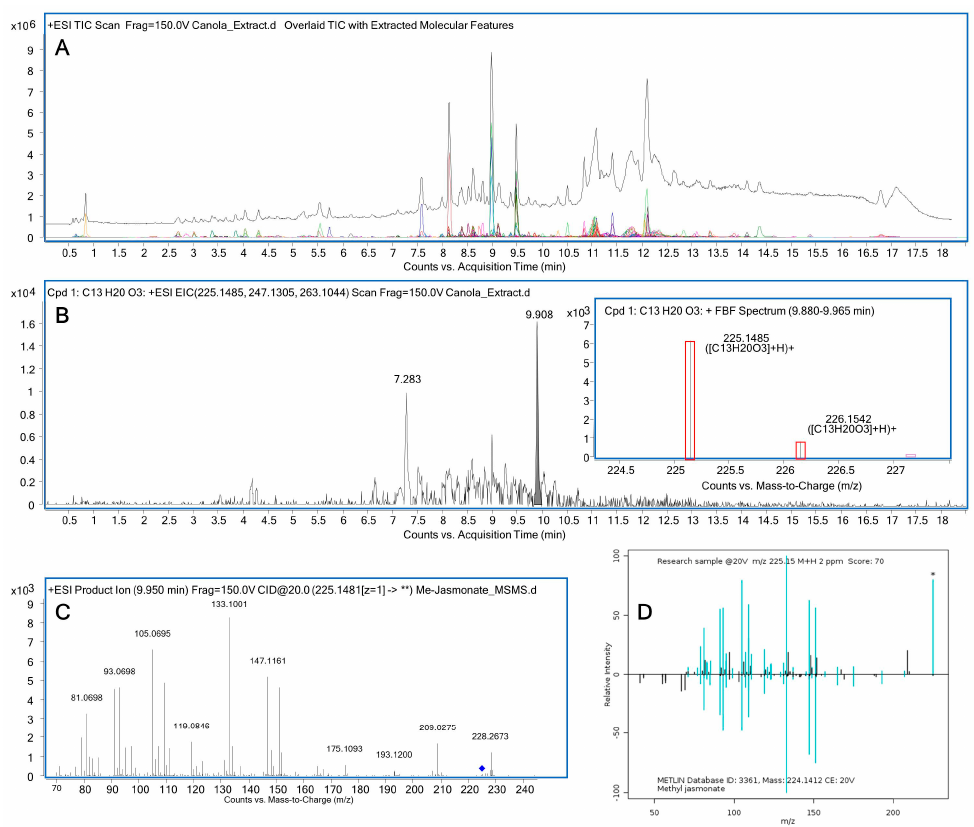
Figure 5. Dereplication and identification strategy using Liquid Chromatography Mass Spectrometry: ( A ) Reverse Phase ESI + Total Ion Chromatogram with overlaid Extracted Molecular Features of Canola Extract; ( B ) Extracted Ion Chromatogram of the molecular formula corresponding to the plant hormone methyl jasmonate with inlaid Find-by-Formula Spectrum showing observed and predicted isotopic abundance for the feature at 9.880–9.965 min; ( C ) Product Ion spectra of methyl jasmonate using collision voltage of 20.0 eV; ( D ) Spectral match of methyl jasmonate MS/MS spectra to the METLIN Database allowing Putative identification.